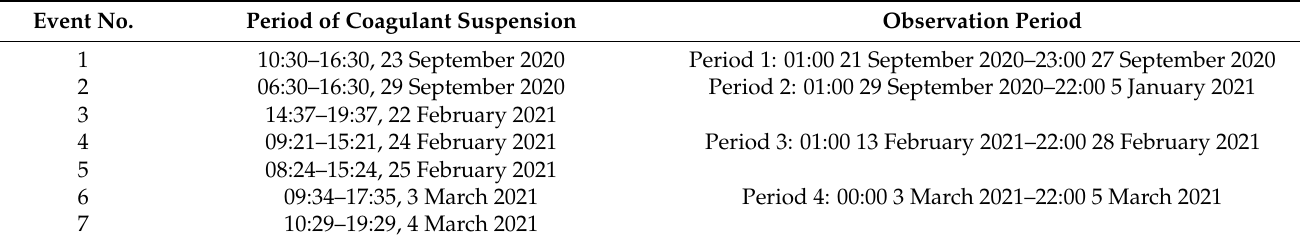
Table 2. Operation scenario of water treatment plant disturbance. Event No.